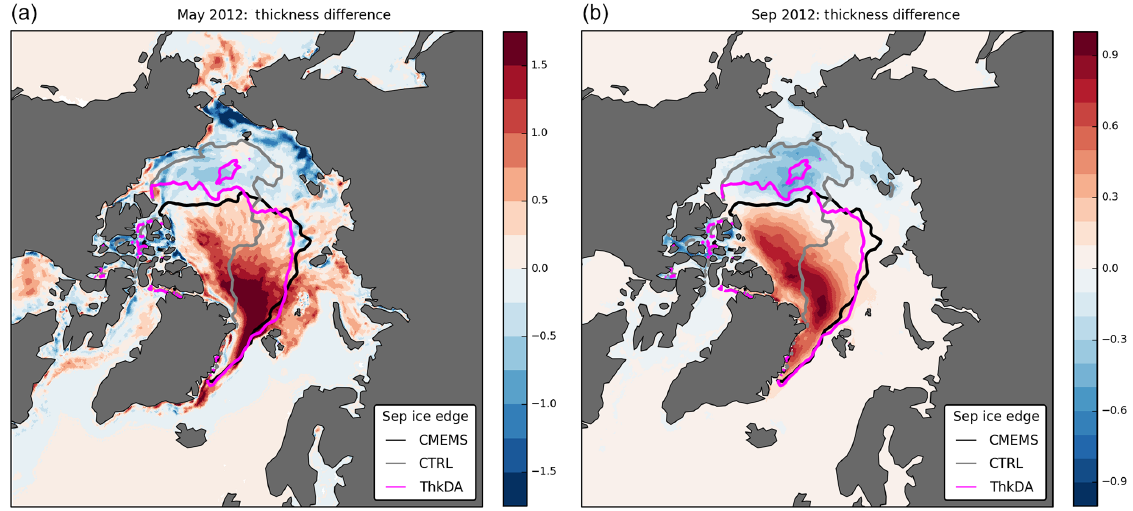
Figure 7. Thickness difference (m) between ThkDA and CTRL experiments in May and September 2012 (contour shading), with differences calculated as ThkDA – CTRL in each case. Panel (a) shows the difference between the reanalyses fields used to initialize the seasonal predictions on 1 May 2012. Panel (b) shows ensemble mean forecast differences for September 2012. (Note the different scales used for the coloured shading). Overlain on both panels are September-mean contours of 15% ice concentration to represent the sea ice edge for the CTRL-HC (grey) and ThkDA-HC (pink) experiments along with the CMEMS reanalysis product